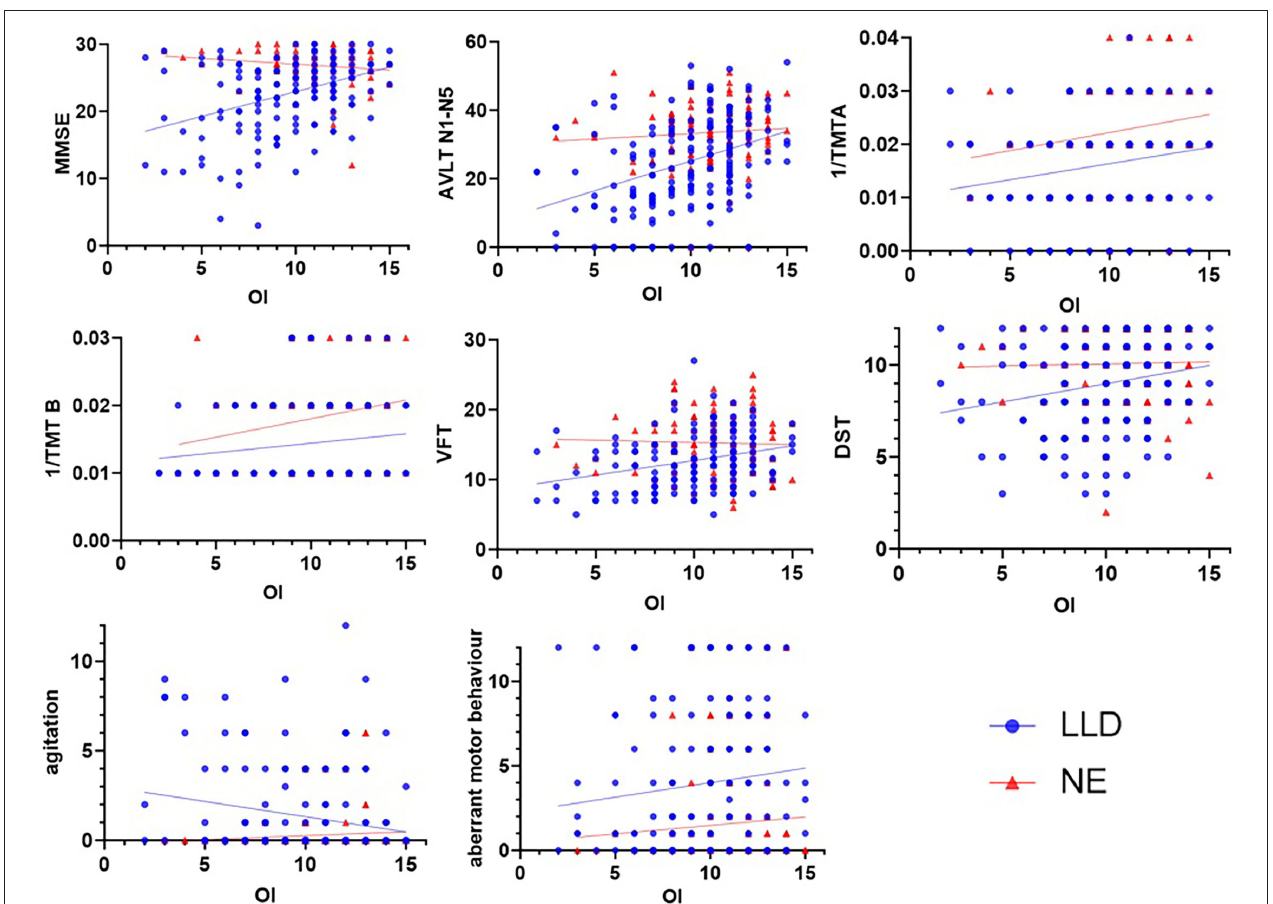
FIGURE 1 | Correlations among OI, cognitive scores and NPI scores. In the NE group, OI was correlated with 1/TMTA ( r = 0.231, p = 0.020) and 1/TMTB ( r = 0.212, p = 0.034). In the LLD group, OI was correlated with MMSE ( r = 0.369, p < 0.001), AVLT N1-N5 total ( r = 0.351, p < 0.001), 1/TMTA ( r = 0.184, p = 0.025), 1/TMTB ( r = 0.195, p = 0.019), VFT ( r = 0.288, p < 0.001), and DST ( r = 0.220, p = 0.007); OI was correlated with NPI scores, including agitation ( r = − 0.200, p = 0.010) and aberrant motor behavior ( r = − 0.165, p = 0.035). LLD, late-life depression; NE, normal elderly; MMSE, Mini-Mental State Examination; AVLT, Auditory Verbal Learning; TMT, Trail-Making Test; VFT, Verbal Fluency Test; DST, Digital Span Test.